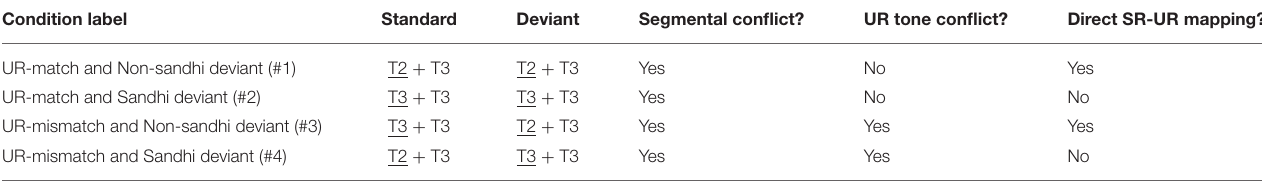
TABLE 1 | A summary of experimental